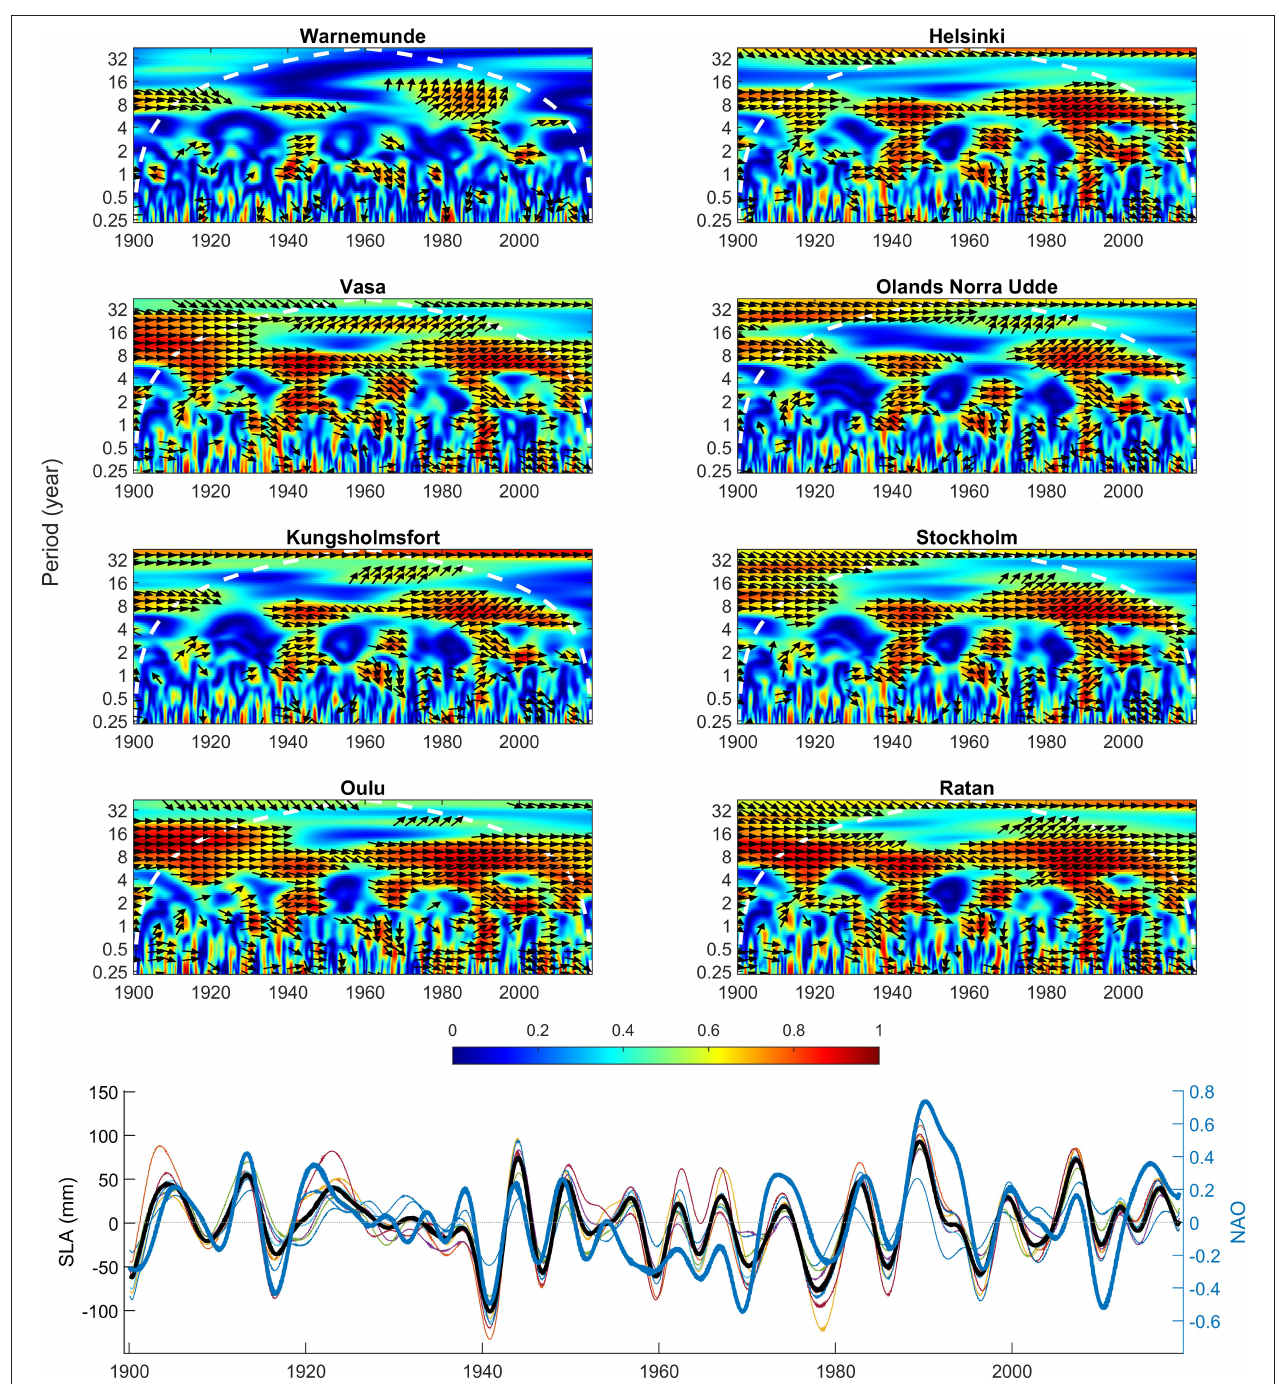
FIGURE 3 | The wavelet coherency between North Atlantic Oscillation (NAO) and tide gauges (top four rows). The arrows represent the phase of the coherence as such to the right represents in phase and the left represents the opposite phase. NAO has a significant role in sea level variations of the Baltic Sea on seasonal to decadal time scales. The bottom panel shows the time series for the sea level anomaly (SLA) and NAO after removing periods shorter than 4 years. In the bottom panel, the thinner curves are for the individual tide gauge time series and the black curve is the mean of them. NAO is represented by thick blue line. The impact of NAO on the interannual to decadal time scale is not constant and it shows a higher correlation for some periods, for instance in the 1940s.